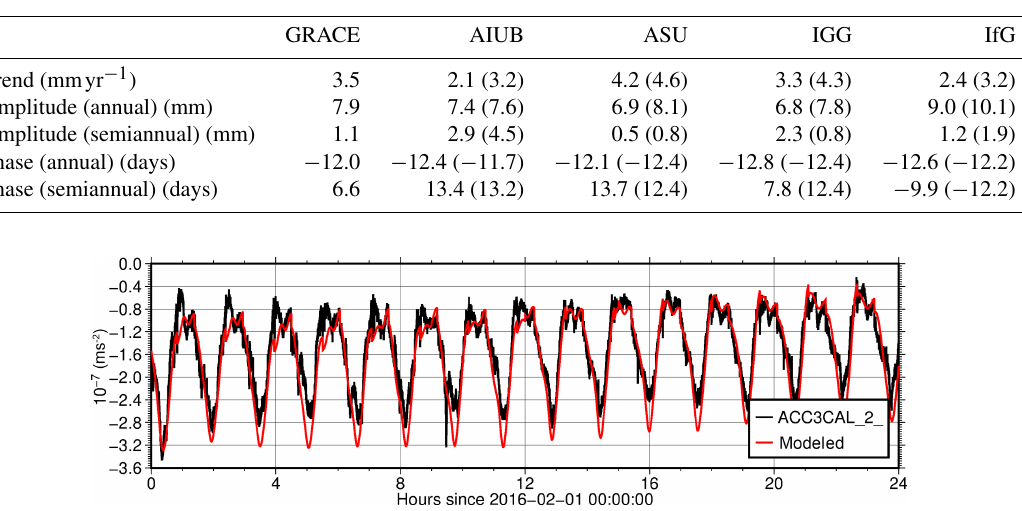
Figure 4. Along-track acceleration of Swarm C. The black curve shows the ACC3CAL_2_ product from Siemes et al. (2016), while the red curve shows our modeled non-gravitational accelerations without applying any bias or scale factors.